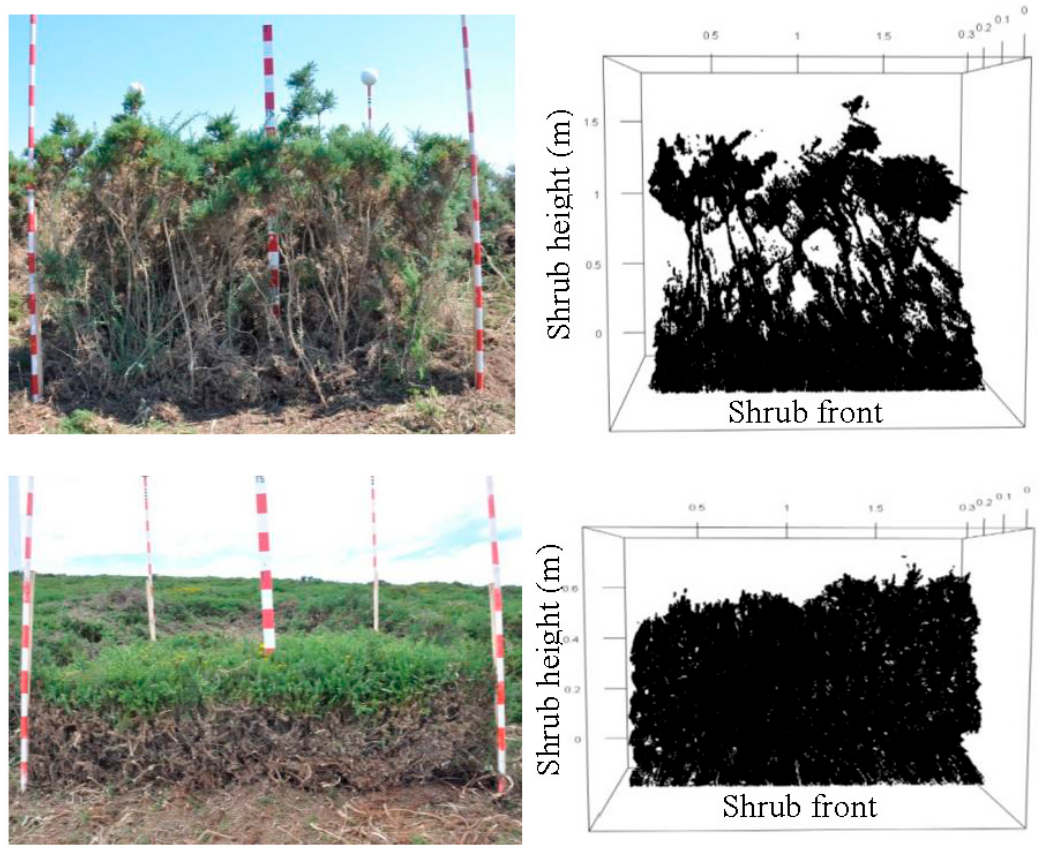
Figure 2. Examples of sample plots with Ulex europaeus ( upper ) and Ulex gallii ( lower ) and terrestrial laser scanning (TLS)-derived laser returns cloud obtained after raw data processing.